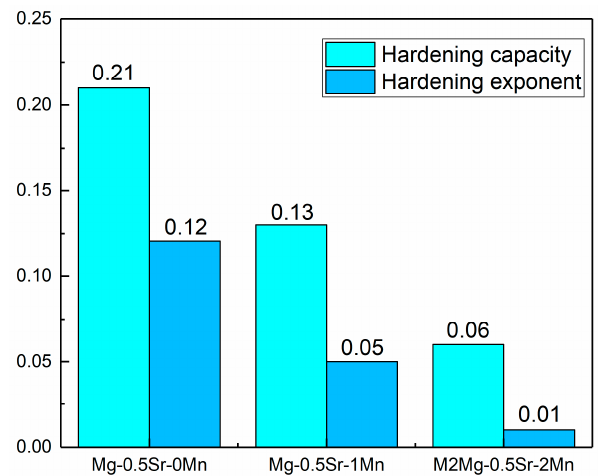
Figure 8. Hardening capacity and hardening exponent plots of the as-extruded Mg-Sr-Mn alloys.